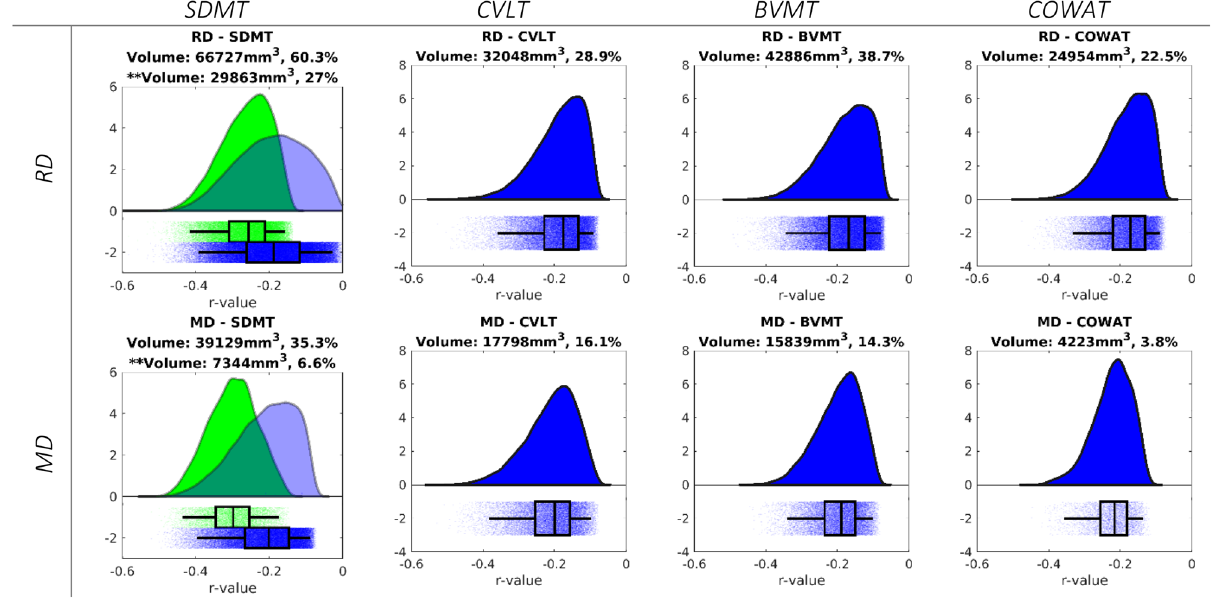
Figure 2. Distribution of r-values from the voxel-wise Pearson correlations between the diffusion tensor parameters and neuropsychological z-scores, for the significant voxels of the TFCE analysis. Results using the cut-off of 0.001 are shown in green and the corresponding volume is indicated with **. In blue we also show the results of cut-off 0.05 and its corresponding volume.